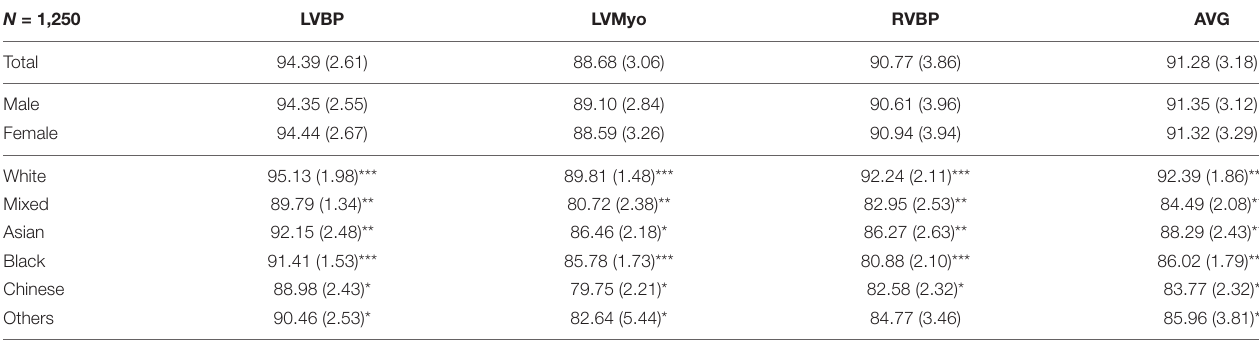
TABLE 2 | Dice similarity coefficient (DSC) values for the overall test set and by sex and race. N =